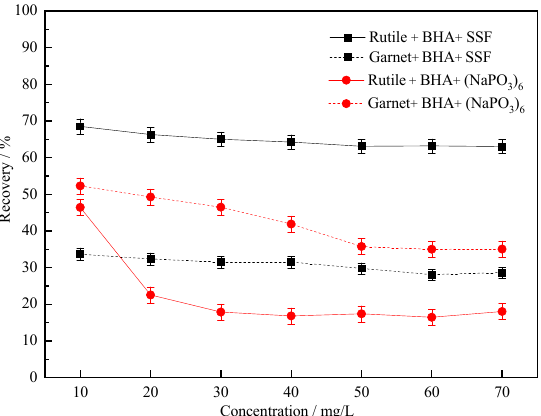
Figure 6. Effect of concentration on the flotation of rutile and garnet by SSF and (NaPO 3 ) 6 (pH = 7, concentration of BHA = 20 mg/L).